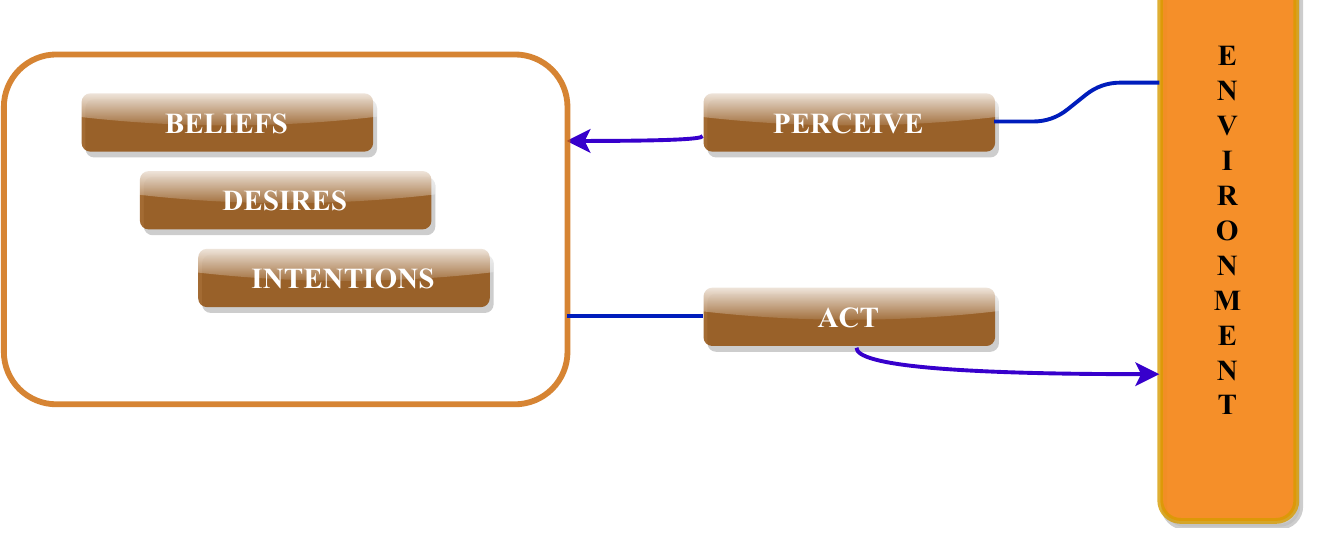
Figure 1. The BDI